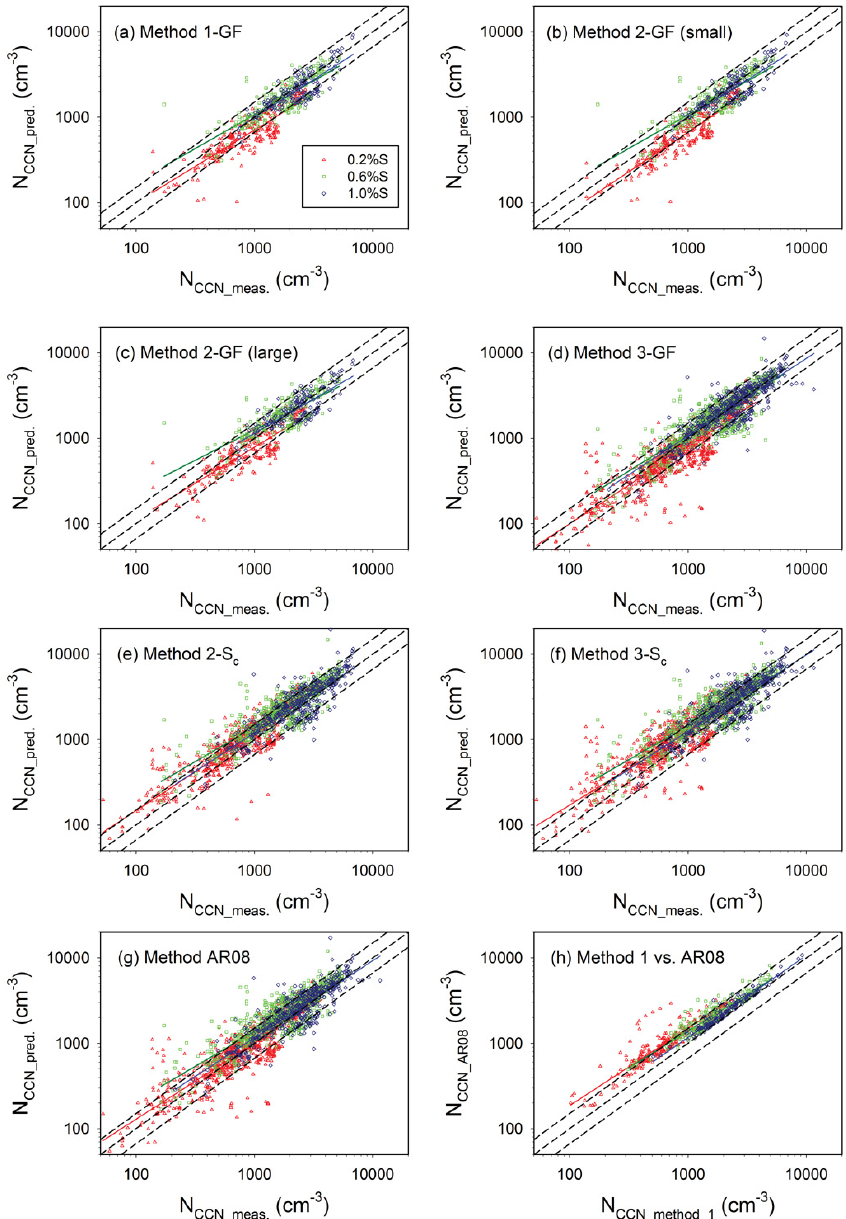
Fig. 12. (a–g) CCN closure results from various methods and (h) comparison between Method 1 and Method AR08. For the description of each method, see Table 5. The dotted lines indicate ± 50%